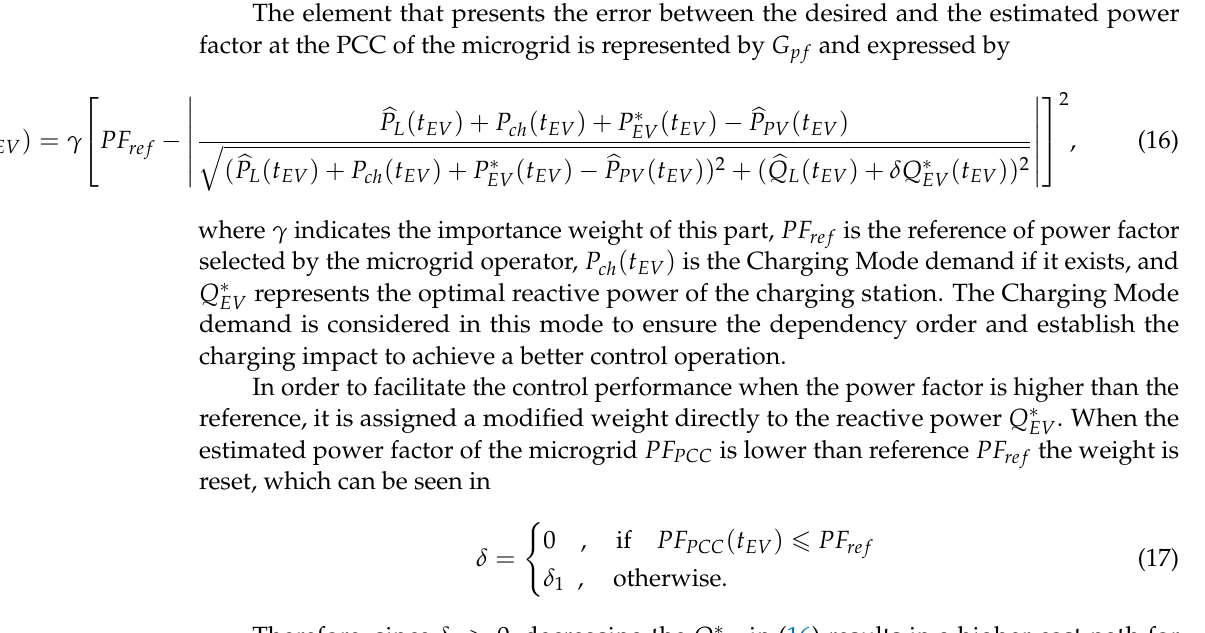
Figure 4. Schematic diagram of the G pf